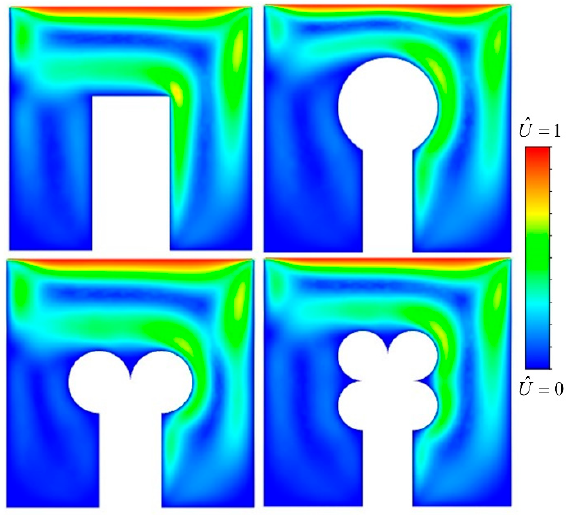
Figure 10. Velocity contours for each of the fins at Re = 100 and Ra = 10 6 , illustrating the convection currents formed due to the difference in density between hot and cold fluid.